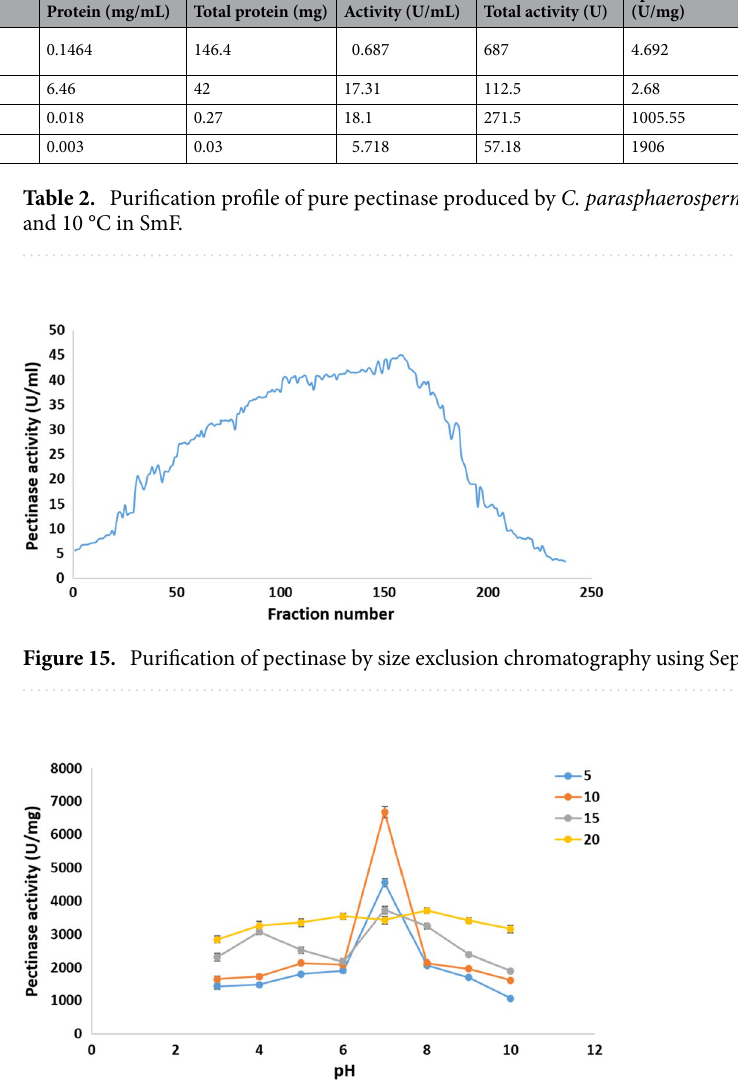
Figure 16. Effect of pH and temperature on activity of the pure